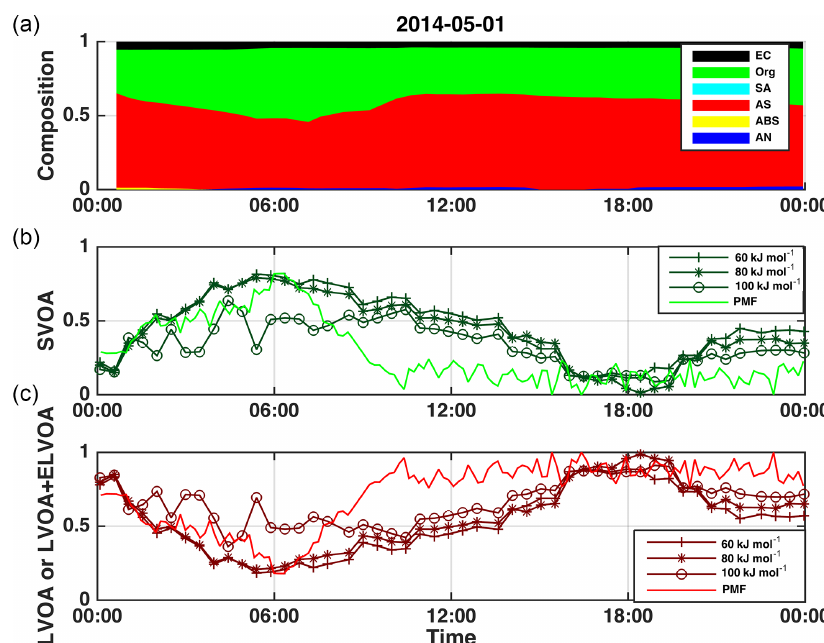
Figure 8. Time series of particle chemical composition obtained from HR-AMS (a) , mass fractions of VTDMA- and PMF-derived SVOA (b) and mass fraction of VTDMA- (the sum of LVOA + ELVOA) and PMF-derived LVOA (c) on 1 May